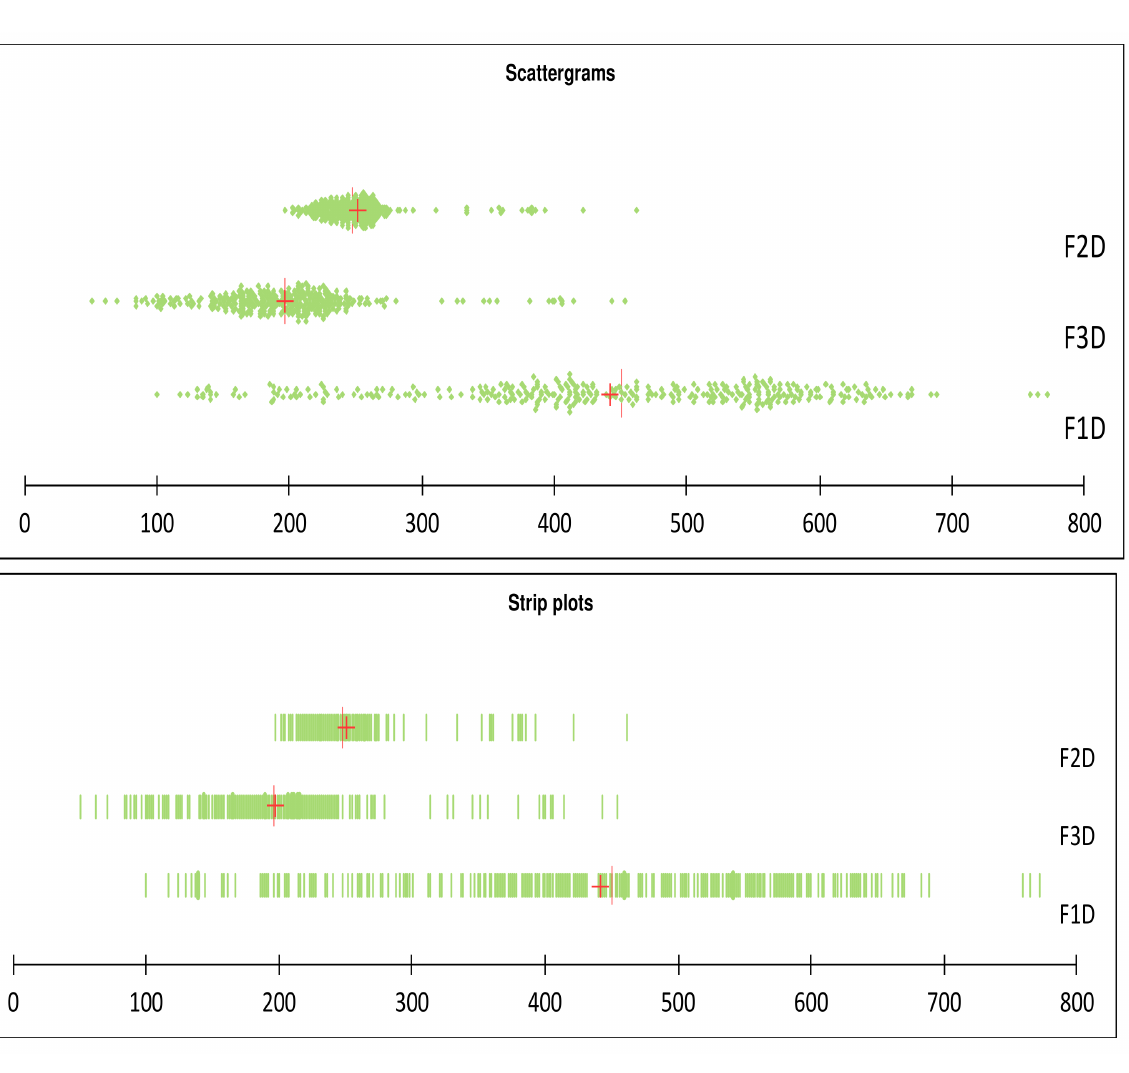
Figure 18. Scatter grams and strip plots of the repartition of the daily water supply on the scientific campus in 2015. Table 10. Statistical descriptive analysis of the daily water supply of the